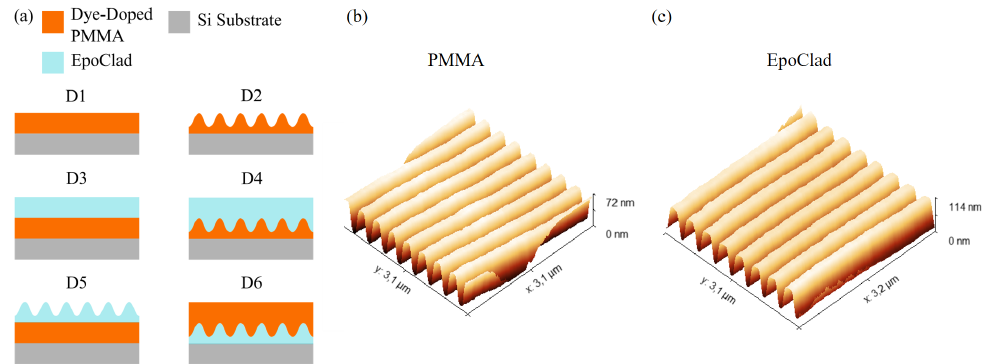
Figure 1. ( a ) Six different sample designs were produced to find out the best sample model. The grating profile on the ( b ) PMMA layer and the ( c ) EpoClad layer were